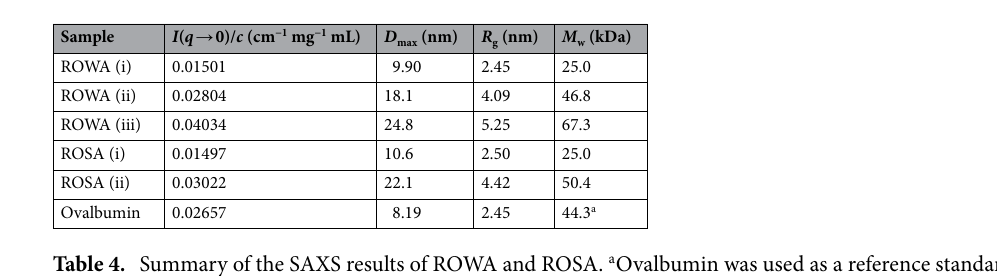
Figure 4. SAXS analysis. Concentration-normalised absolute scattering intensities of the ( A ) ROWA and ( B ) ROSA samples. Concentration-normalised pair-distance distribution functions of the ( C ) ROWA and ( D ) ROSA samples. The samples of the eluted peaks were fractionated by SEC purification as shown in Fig. 3. Ovalbumin was used as a reference standard of the molecular mass.